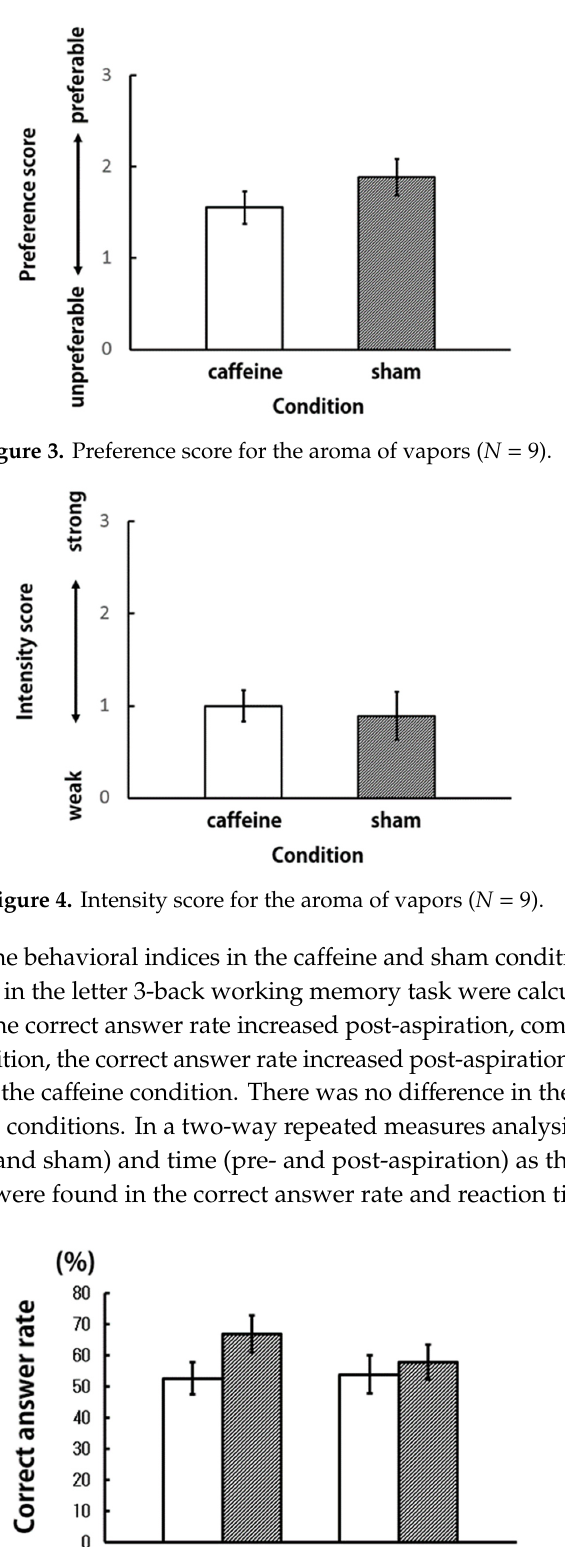
Figure 6. Response time of the letter 3-back working memory task ( N = 9). The brain activity in the theta band was calculated for a 4-minute epoch, separately for the pre- and post-aspiration letter 3-back working memory task. A two-way repeated measures ANOVA was performed with treatment (caffeine and sham) and time (pre- and post-aspiration) as the dependent variables, and the log-transformed (10 × log10 ( μ V 2 )) theta band power (5 − 7 Hz) as the independent variable. We observed significant interactions for F8, F4, C4, and T4 ( p < 0.05) (Table 1, Figure 7). Theta-band power differences between post- and pre-aspiration during the letter 3-back working memory task in the caffeine and sham conditions were calculated. The averages of all nine participants in the experiment are presented in Table 1. Table 1. Theta-band power differences between post- and pre-aspiration during the letter 3-back working memory task in the caffeine and sham conditions ( N = 9). Treatment Condition Caffeine